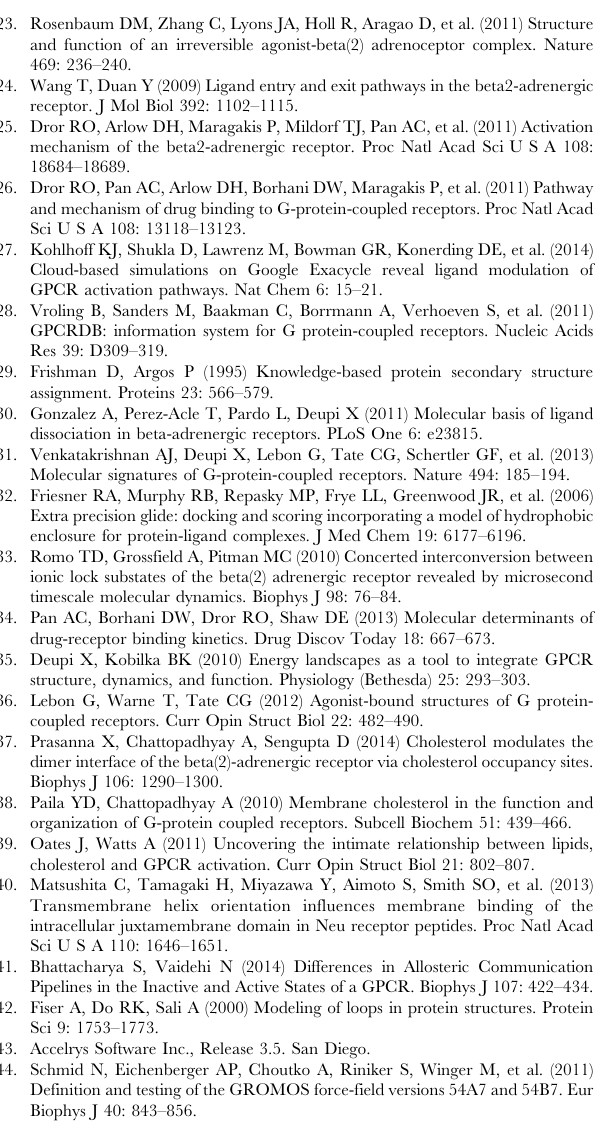
S1 Table Class A GPCRs from the GPCRDB which include full/partial N-terminal coordinates. (PDF) S2 Table Contacts of the N-terminal residues with the rest of the receptor that are within 0.3 nm for at least 30% of simulation time. (PDF) S3 Table Templates used to model the N-terminal region of human b 2AR